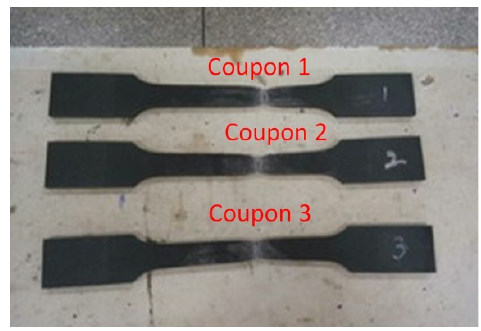
Figure 7. Fabricated LYP steel coupons.